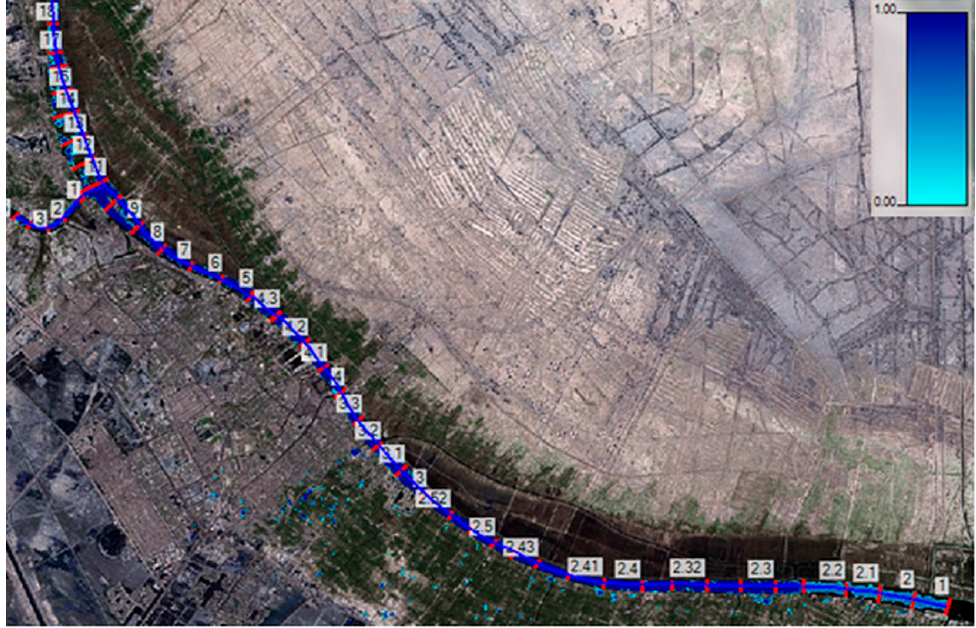
Figure 22. Flood extent generated by HEC-RAS 5.03 at the end of the wave period for case B2.